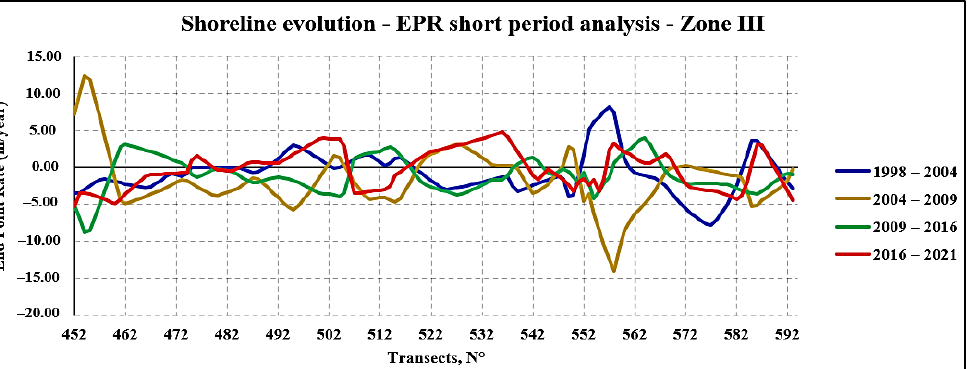
Figure 13. Accretion and erosion profiles obtained in zone III by applying the End Point Rate (EPR).